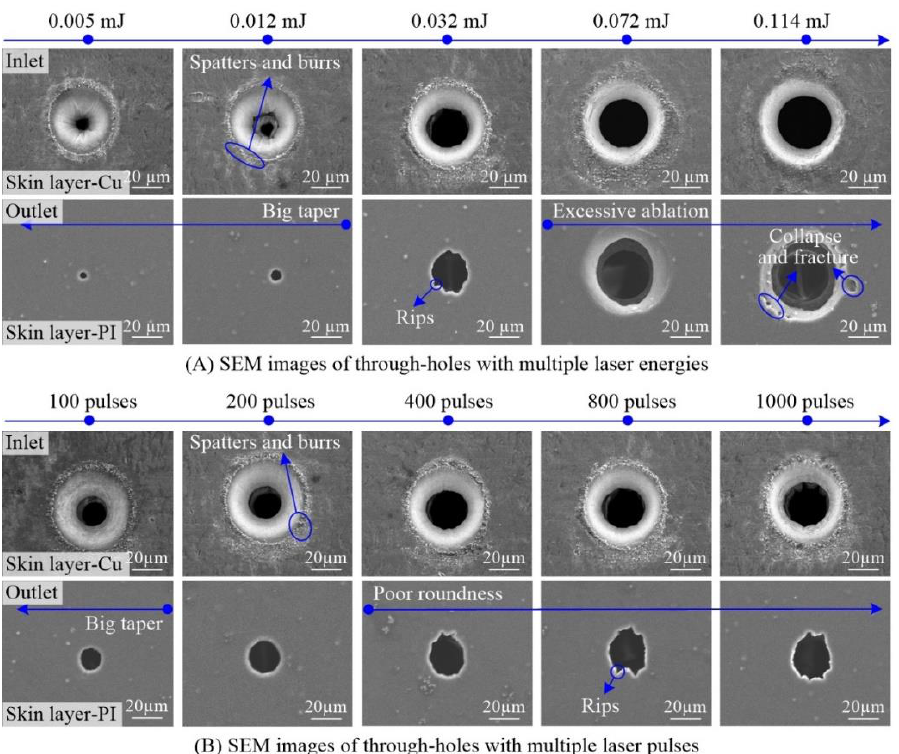
Figure 5. Effect of laser energy and pulses on the through-holes in single-sided board with the laser wavelength of 532 nm (( A ) 500 pulses; ( B ) Energy of 0.032 mJ).